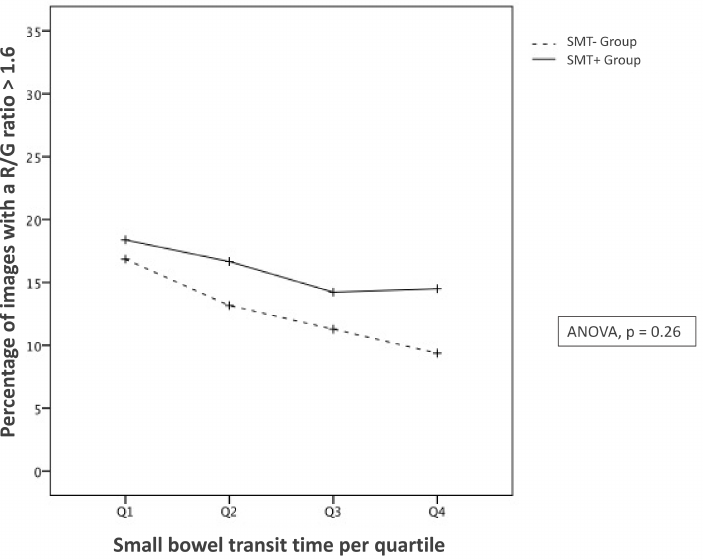
Figure 3. Interaction plot between the two groups about the percentage of images with a R/G ratio over 1.6 by quartile. SMT − stands for “without simethicone” whereas SMT+ means “with